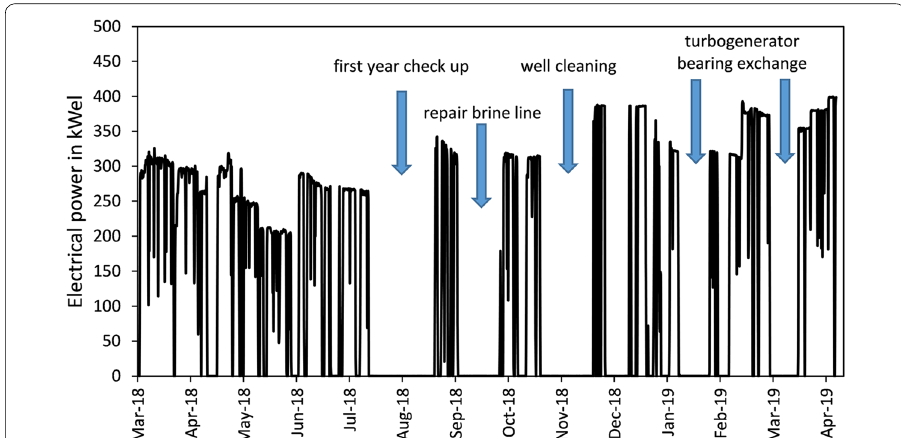
Fig. 6 Power output of the demonstration plant in 2018